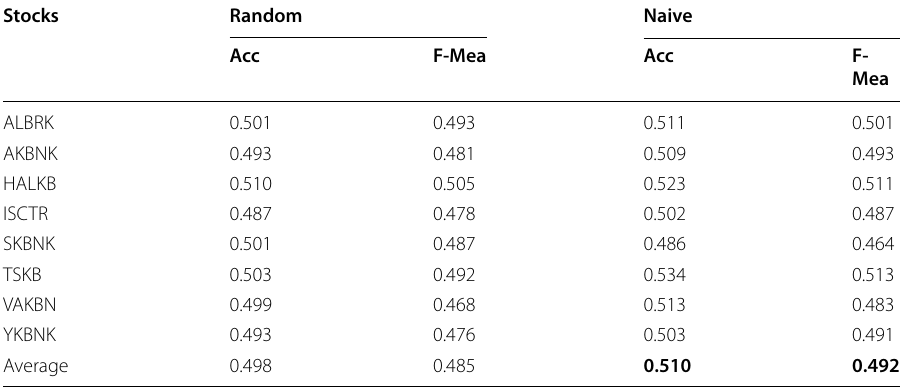
Bold numbers indicate the best performance